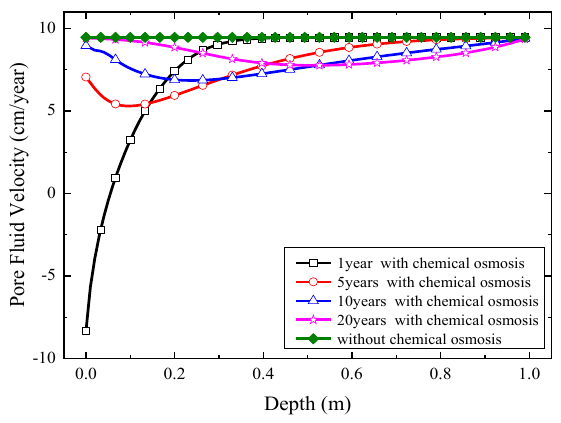
Figure 4: Distribution of pore fluid velocity with depth.